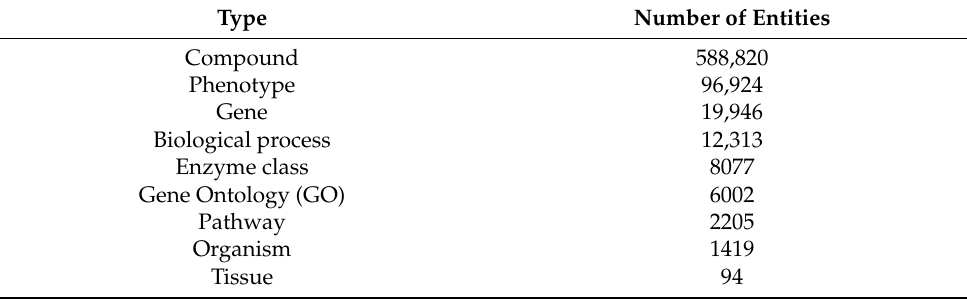
Table 1. Descriptive statistics of entities extracted from